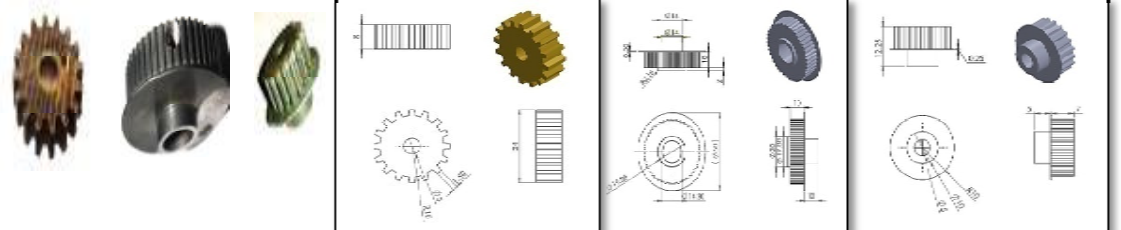
Fig. 5. The Toothed